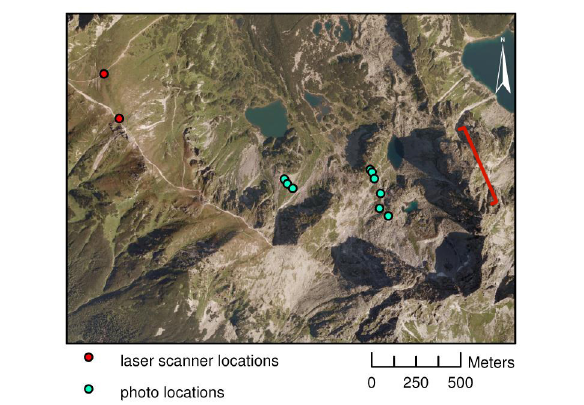
Figure 2. Scanner and camera locations in the upper part of the G ą sienicowa Valley. Ko ś cielec ridge is marked with the red bracket